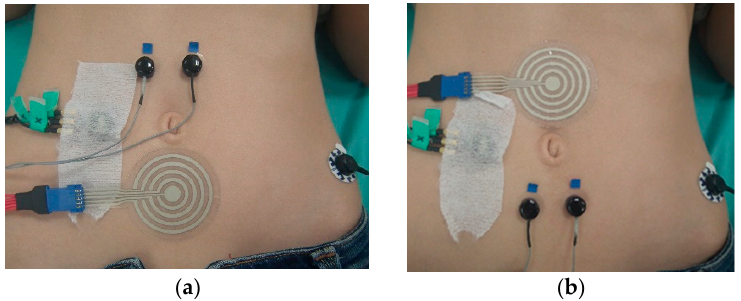
Figure 4. Location of electrodes and accelerometer (covered by adhesive tape). ( a ) Multi-CRE in BN position and conventional bipolar recording in AN position, reference electrode for monopolar measurements on left hip; ( b ) multi-CRE in AN position and conventional bipolar recording in BN position.